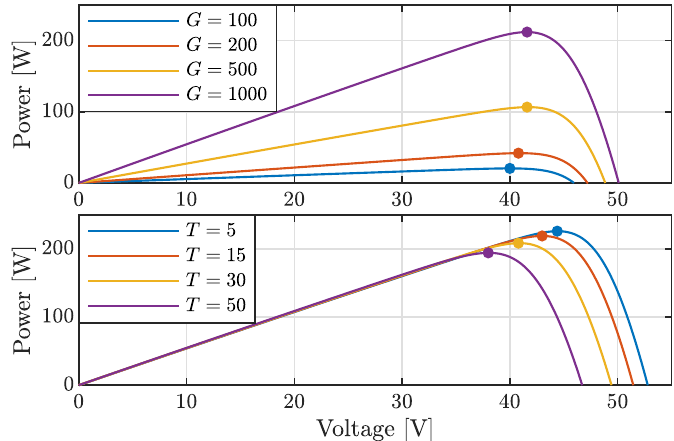
Figure 2. P - V curve for different values of irradiance and